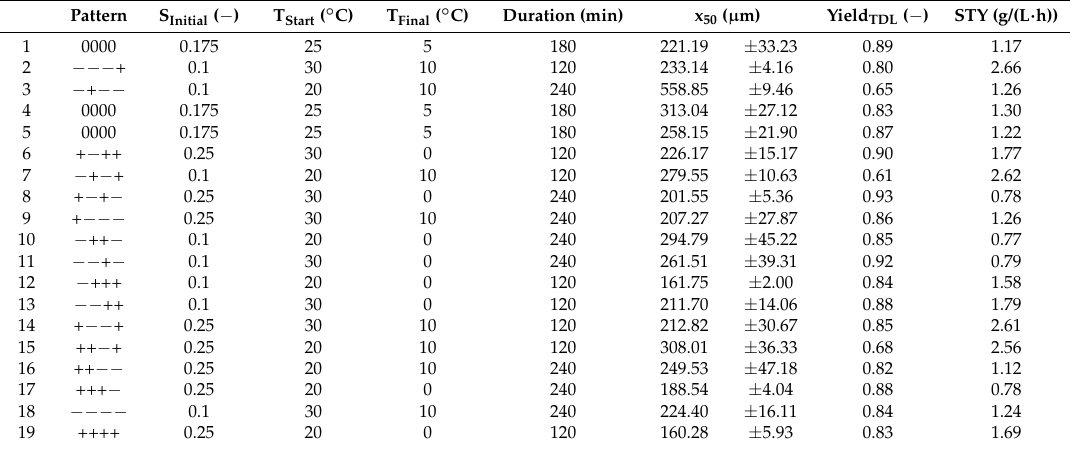
Table 4. Design of experiments for growth experiments (STY: Space-Time-Yield; TDL: Thermodynamic limit).